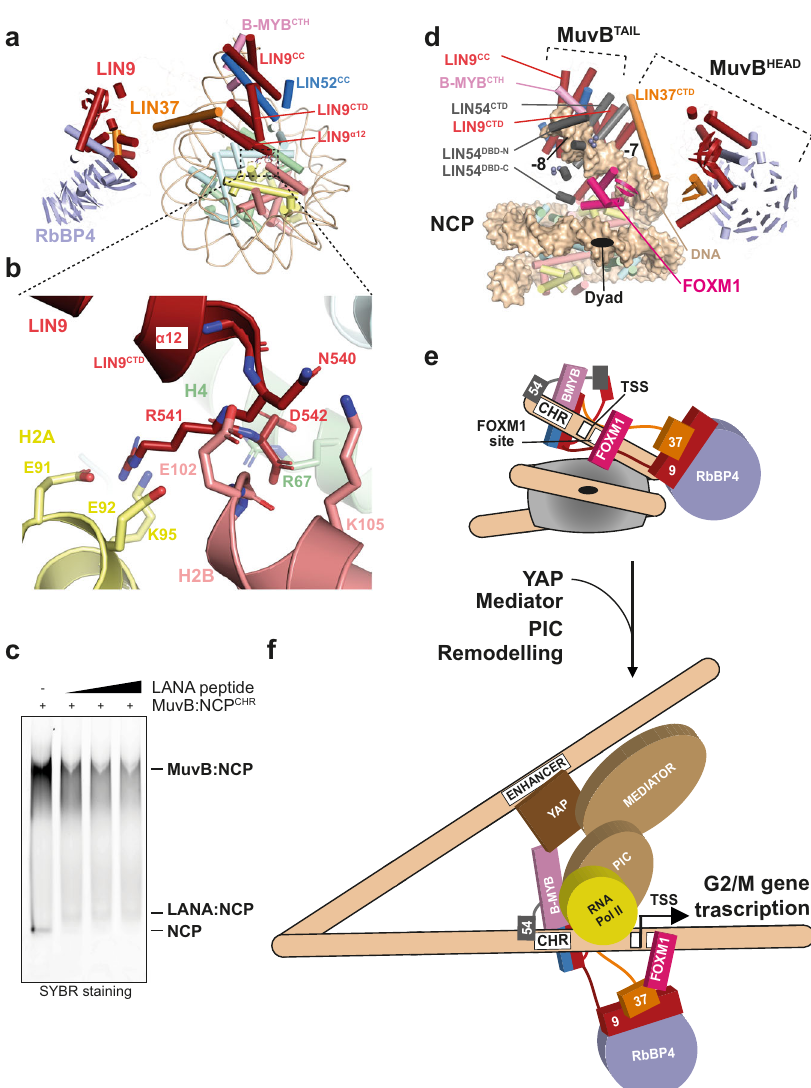
Fig. 5 | Interactions of MMB core with histones and model of pioneer transcrip- tionfactorfunctionoftheMMBcomplex. ThelasthelixofLIN9( α 12)interactwith the nucleosome acidic patch and histone H4. A zoomed view of a is shown in ( b ). Although the resolution of our structural data in this area does not allow for resol- vingside-chains,possibleside-chainsinteractionsbetweentheLIN9C-terminalNRD sequence and residues from H2A and H2B histones (acidic residues are part of the nucleosome acidic patch) and H4 are modelled based on docking of secondary structure elements in the NCP:LIN9 CTD map (Supplementary Fig. 5f, h) and here depicted. c LANA peptide competes with MuvB for binding the nucleosome. A complexofMuvBwithanucleosomecontainingaCHRsequencewasruninanEMSA ineithertheabsenceorthepresenceof increasingconcentrationsofLANApeptide. This experiment was repeated independently three times with similar results. d Modelling of a MMB-FOXM1:nucleosome complex. The AlphaFold model from SupplementaryFig.6dwassuperposedtotheLIN9 CTD .TheinteractionwiththeCHR element was modelled by superposing the DNA from PDB-ID: 5FD3, into the SHL − 8 region of our MMB core :nucleosome complex. FOXM1 was modelled by